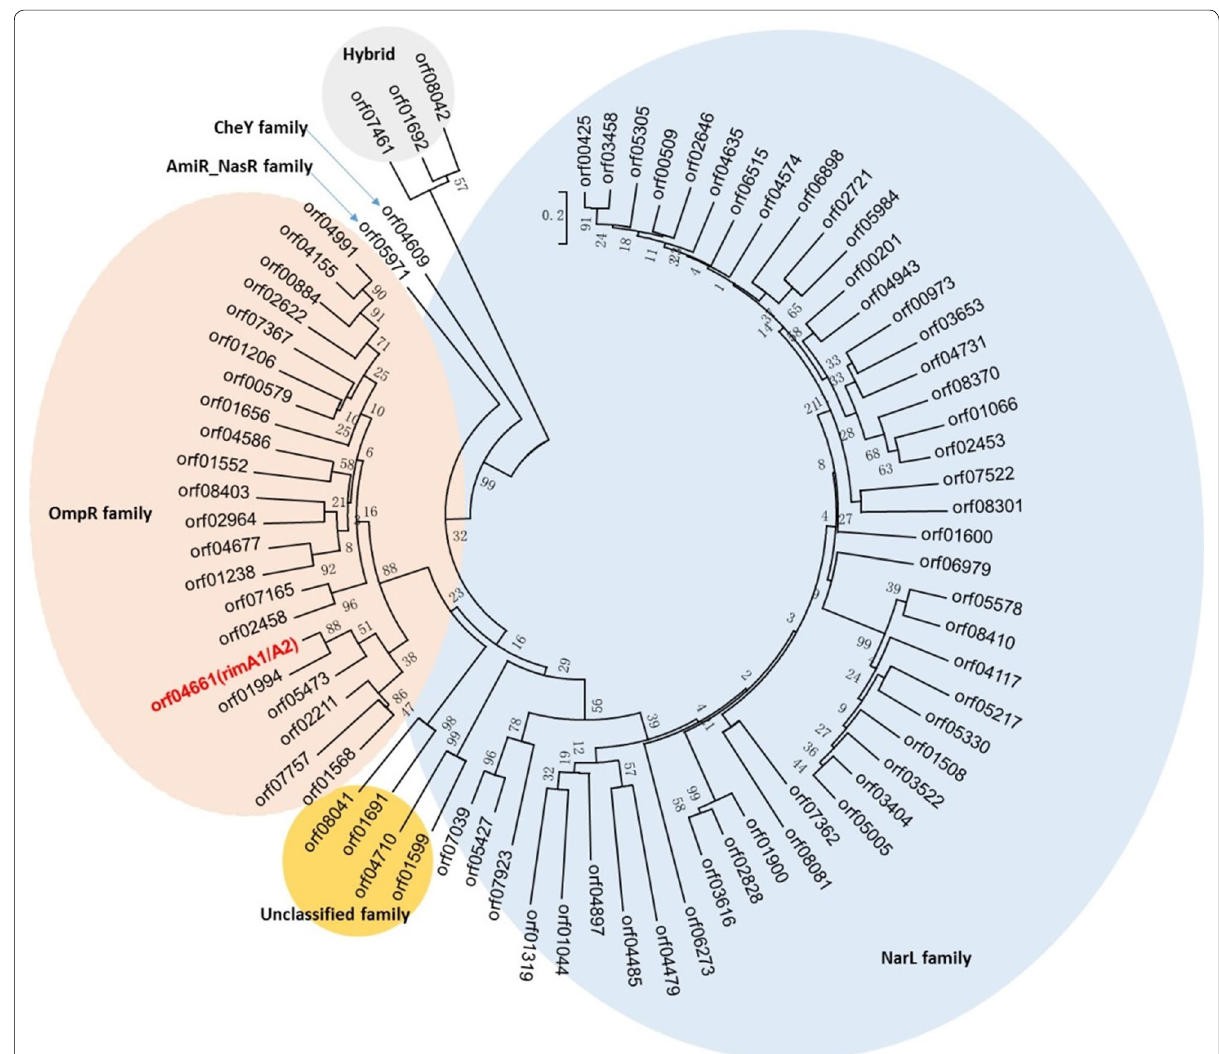
Fig. 1 Phylogenetic analysis of 77 putative response regulators. Most of the response regulators are classified by the relatedness of their output domains. Most response regulators in S. rimosus M4018 belong to OmpR and NarL families. Four response regulators in unclassified family did not fit to any known group (unclassified family). A group of response regulators designated as »Hybrid« represents the sensor kinase-response regulator family containing both transmitter and receiver modules in their primary amino acid sequences